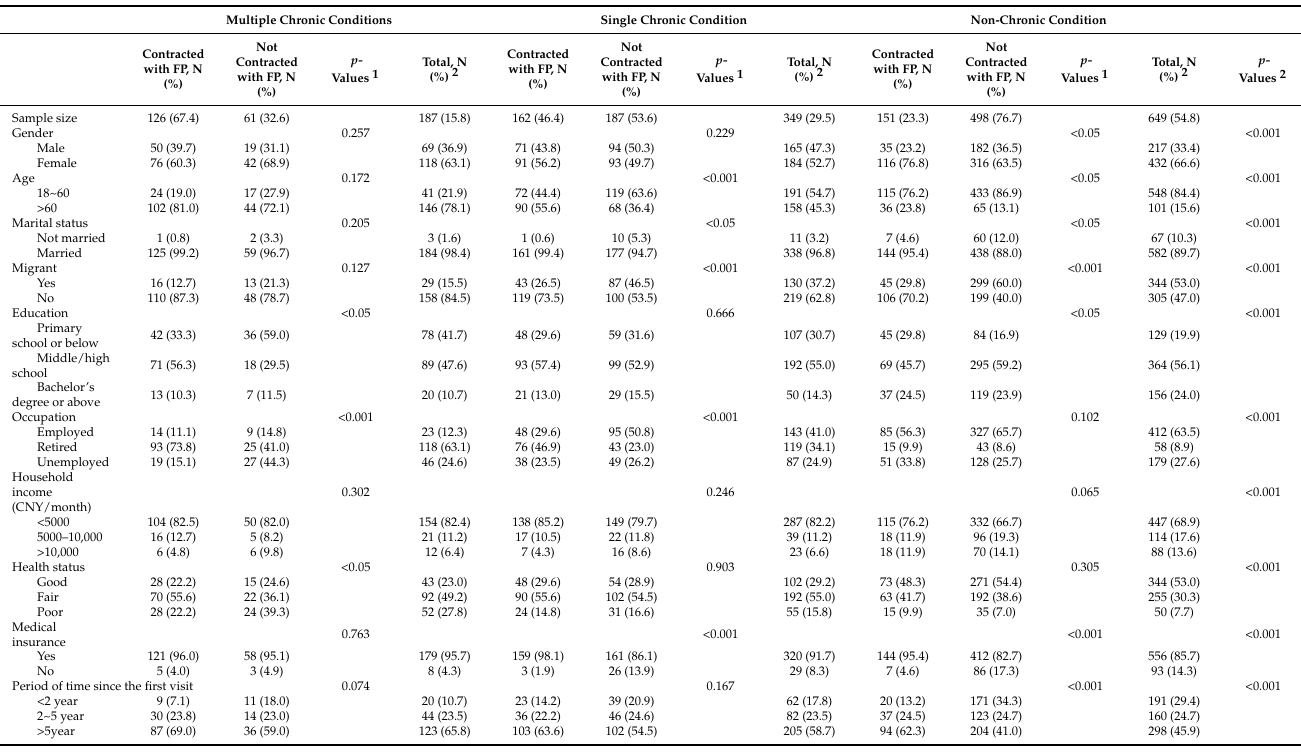
Table 1. Comparison of demographics and health characteristics of respondents between those contracted with family practice services and those not contracted with family practice services by the number of chronic